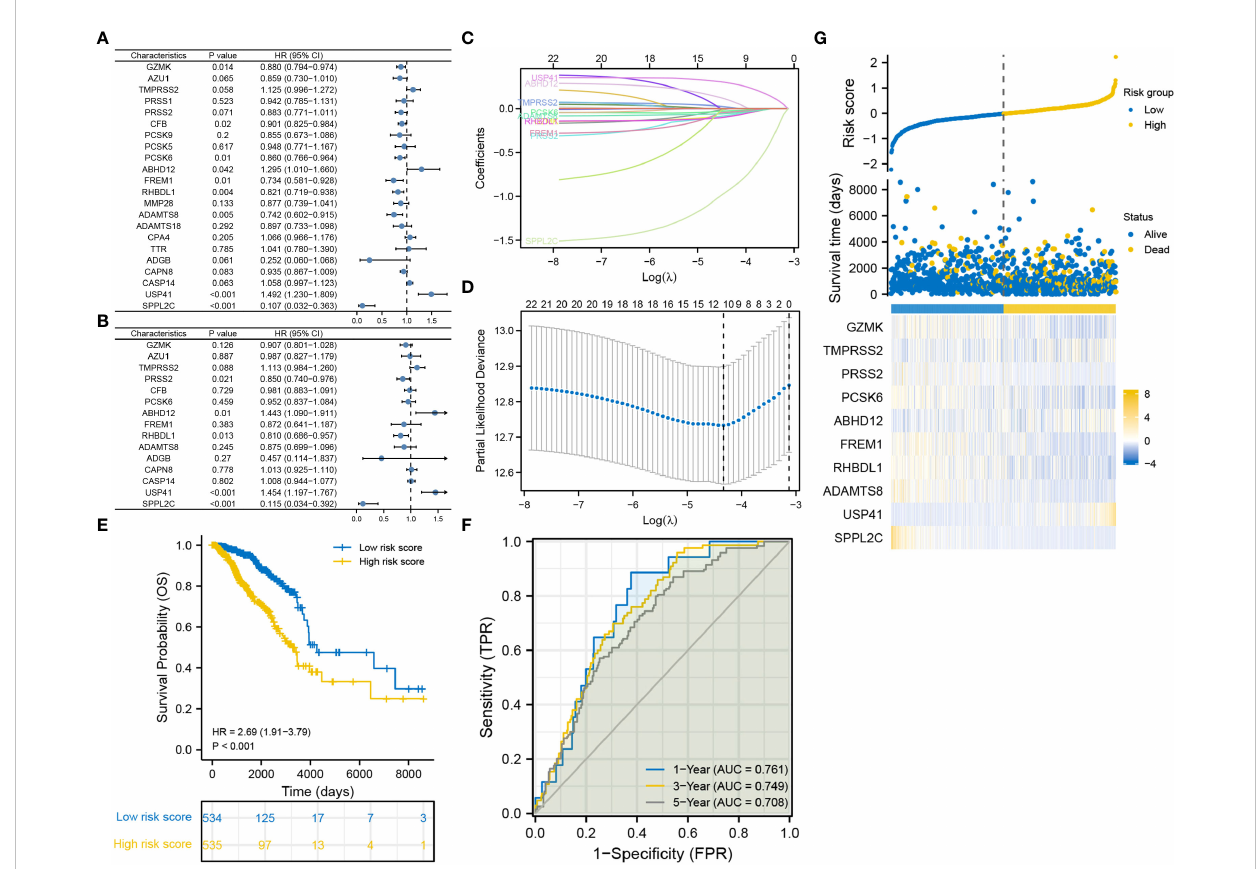
FIGURE 2 Construction of the degradome signature via LASSO regression analysis. (A) Univariate Cox regression analysis. (B) Multivariate Cox regression analysis. (C, D) LASSO regression analysis. (E) K-M curve for comparing OS between the low- and high-risk groups. (F) ROC curves of the degradome signature at 1-, 3- and 5-year. (G) Distribution of risk scores and survival time (days) between the low- and high-risk